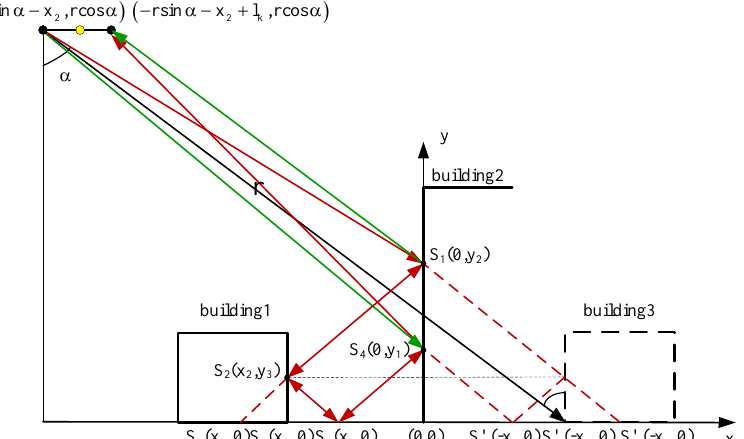
Figure 4. The schematic of FB scattering between combined buildings of airborne array